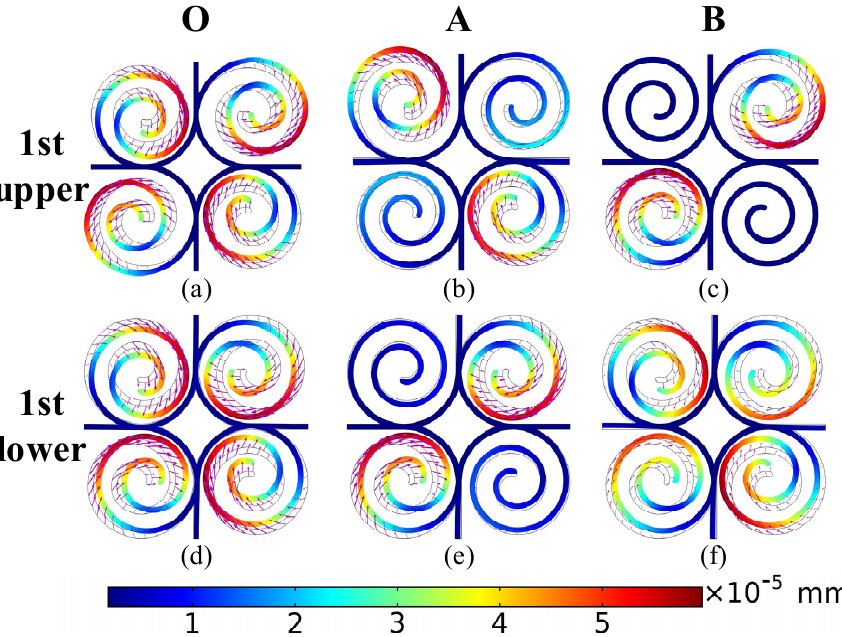
Figure 3. Mode shapes of the proposed structure: ( a – c ) represent the points (O, A, B) of the IBZ on the fourth branches the lower edge of the first bandgap; ( d – f ) represent the points (O, A, B) of the IBZ on the third branches the upper edge of the first bandgap; the arrows represent the magnitude and direction of the displacement of the mode. (For interpretation of the references to color in this figure legend, the reader is referred to the web version of this article.).